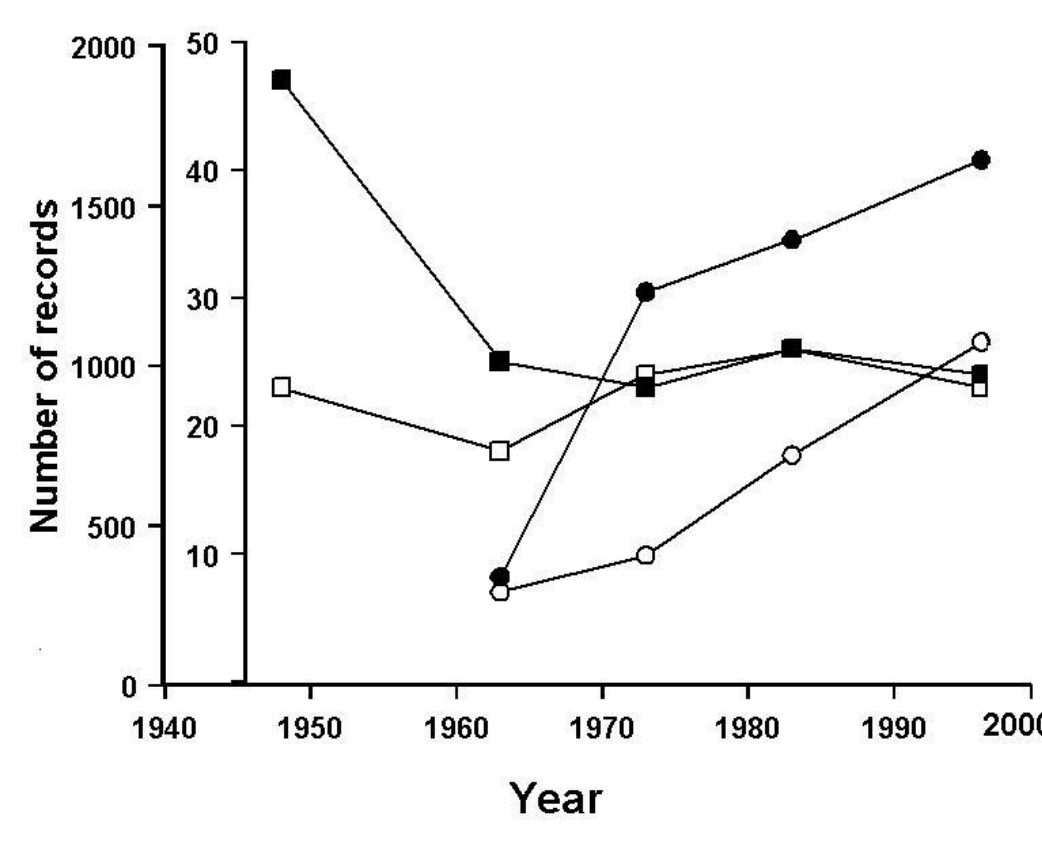
Figure 1. Species records (10 × 10 km 2 ) 1947-1996. Widespread: vivipara ; both with Y-axis up to 2000. Rare: up to